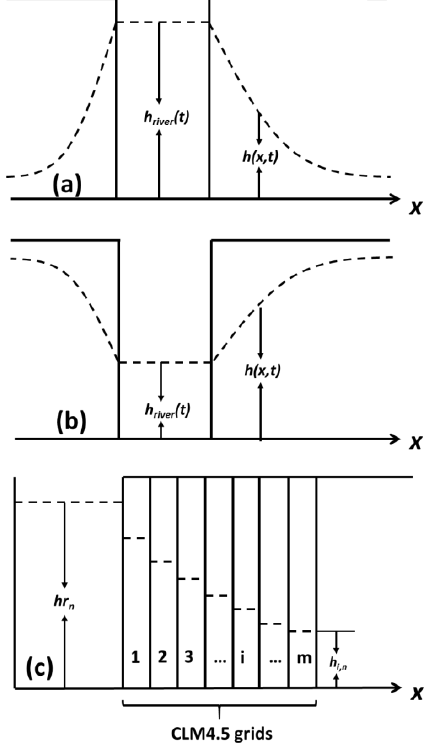
Figure 1. Schematic representation of stream–aquifer water inter- action when (a) the river water level is higher than its neighbor- ing groundwater table and (b) the river water level is lower than its neighboring groundwater table. (c) Schematic diagram for horizon- tal discrete grid cells of a riverbank. The dashed lines represent the water